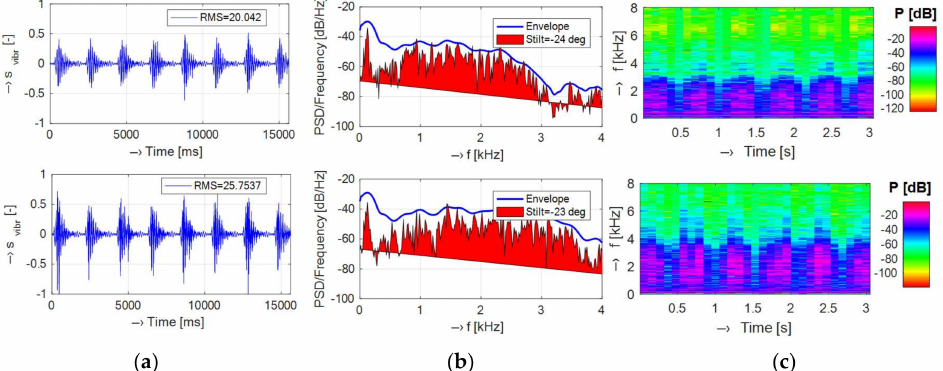
Figure 7. Visualization of basic spectral properties of recorded vibration signals; ( a ) stationary part of a normalized signal with its RMS value; ( b ) spectral density together with its envelope and calculated spectral tilt; ( c ) corresponding spectrograms for MRI Opera (upper set) and TMR96 (lower set).